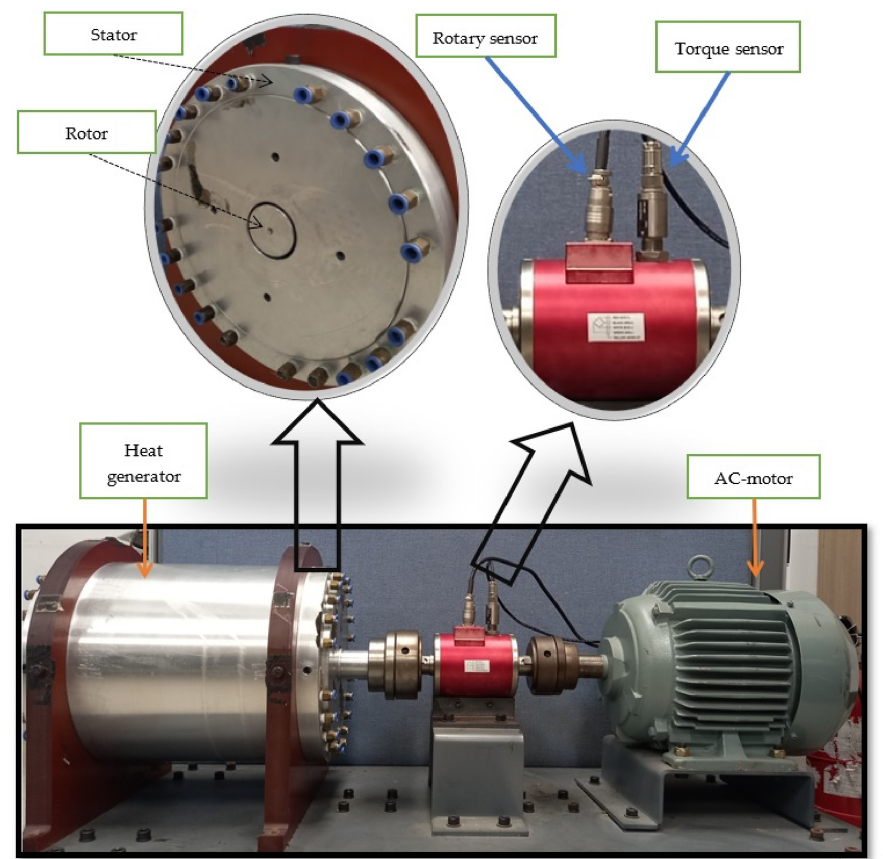
Figure 4. PMECH Test